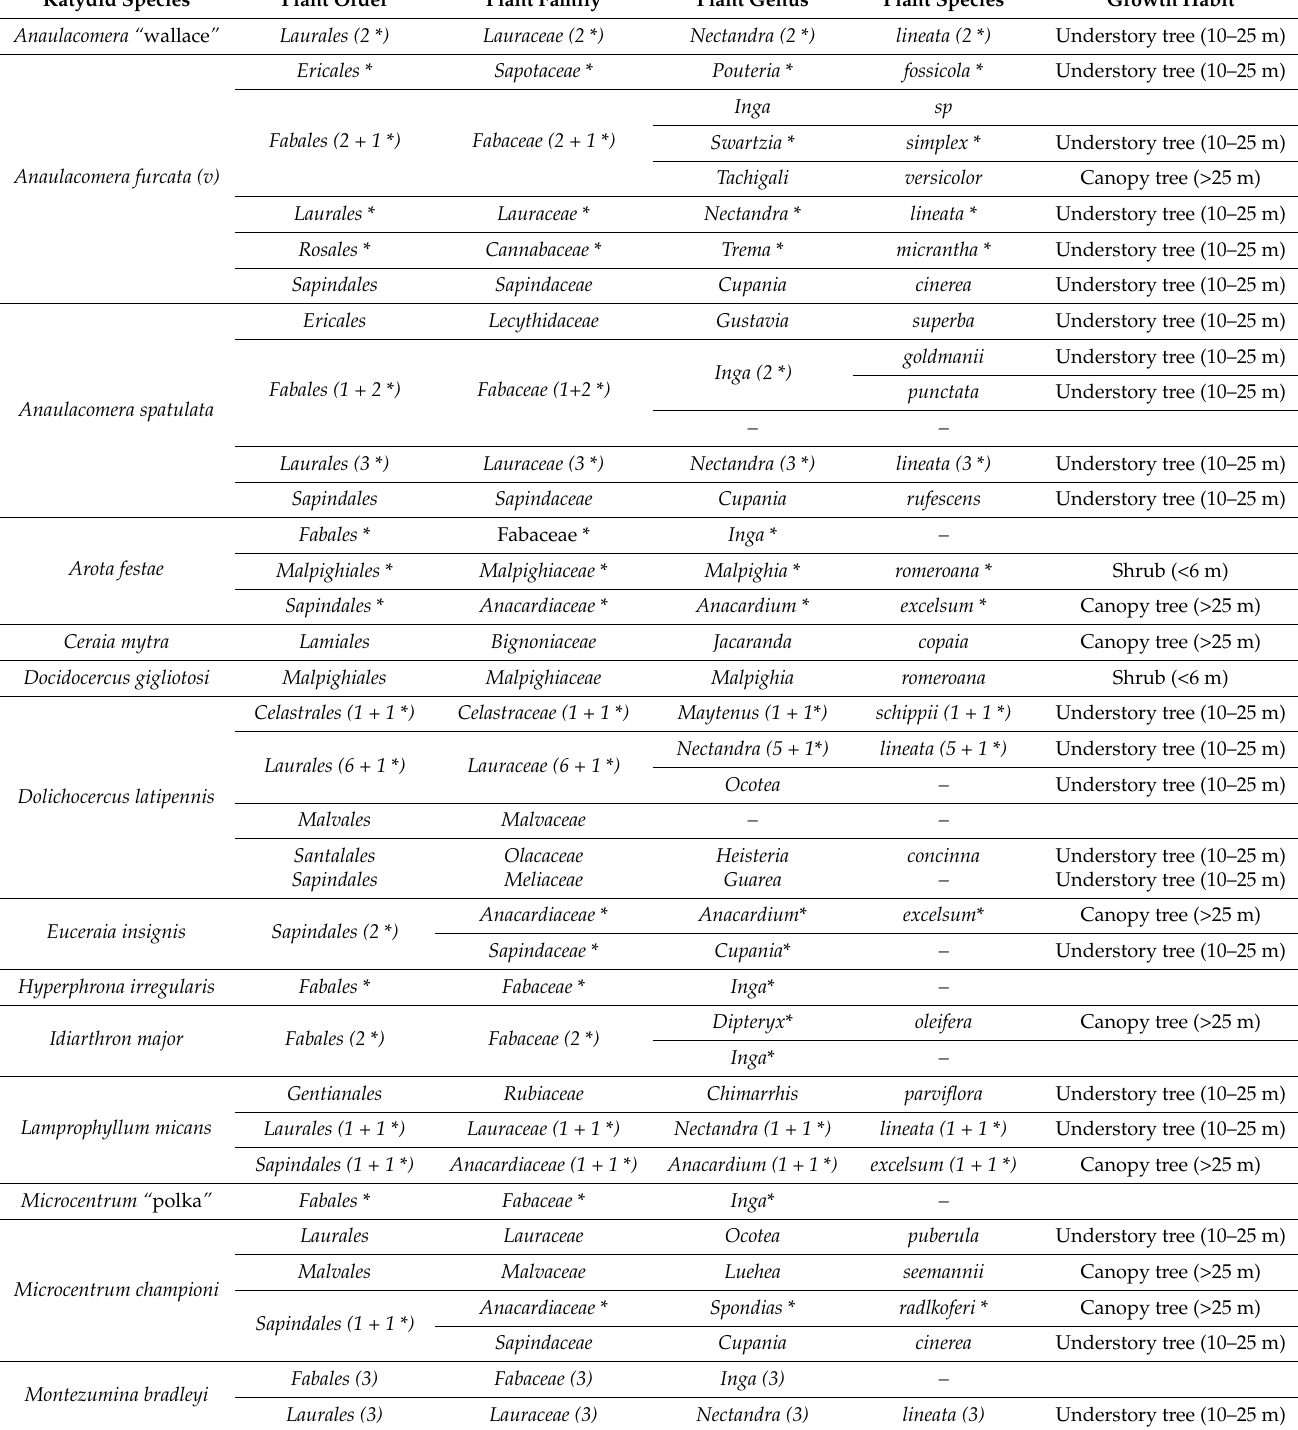
Table 1. Plant species identified by DNA barcoding from the digestive tracts of Neotropical